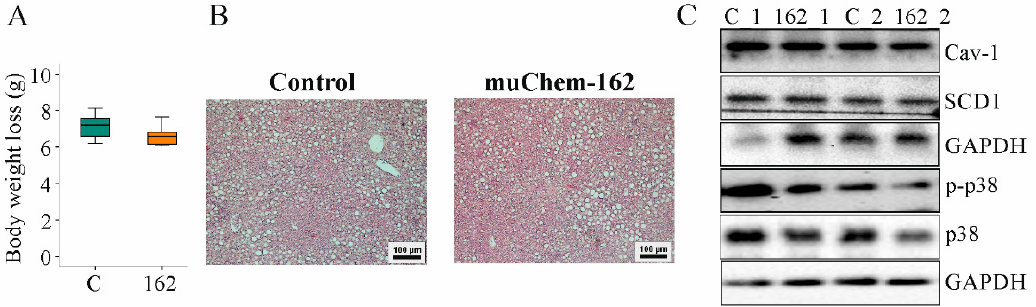
Figure 2. Overexpression of muChem-162 in the liver had no effect on body weight loss, hepatic steatosis, and chemerin signaling in mice fed an methionine–choline deficient (MCD) diet for 2 weeks: ( A ) Body weight loss ( n = 7 mice per group; Mann–Whitney U test); ( B ) Hematoxylin-and-eosin-stained liver; ( C ) Immunoblot analysis of caveolin-1 (Cav-1), stearoyl-CoA-desaturase (SCD) 1, p38 protein, and its phosphorylated form ( p -) in the liver of two control-infected mice (i.e., C_1 and C_2) and two muChem-162-expressing mice (i.e., 162_1 and 162_2).